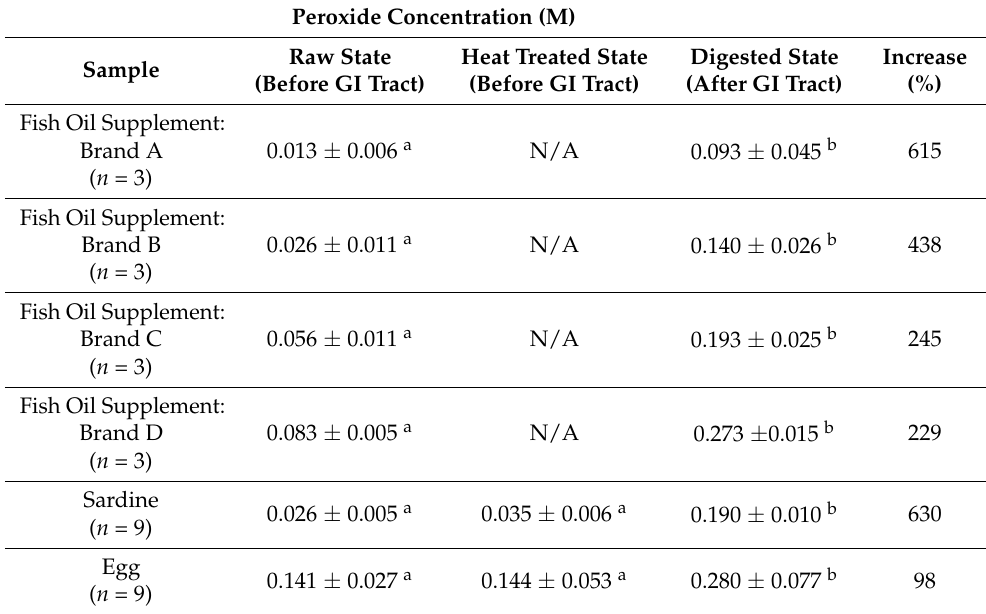
Table values are means ± standard deviations. Different superscript letters in the same row represent statistical differences ( p ≤ 0.05); n represents the number of independent experimental